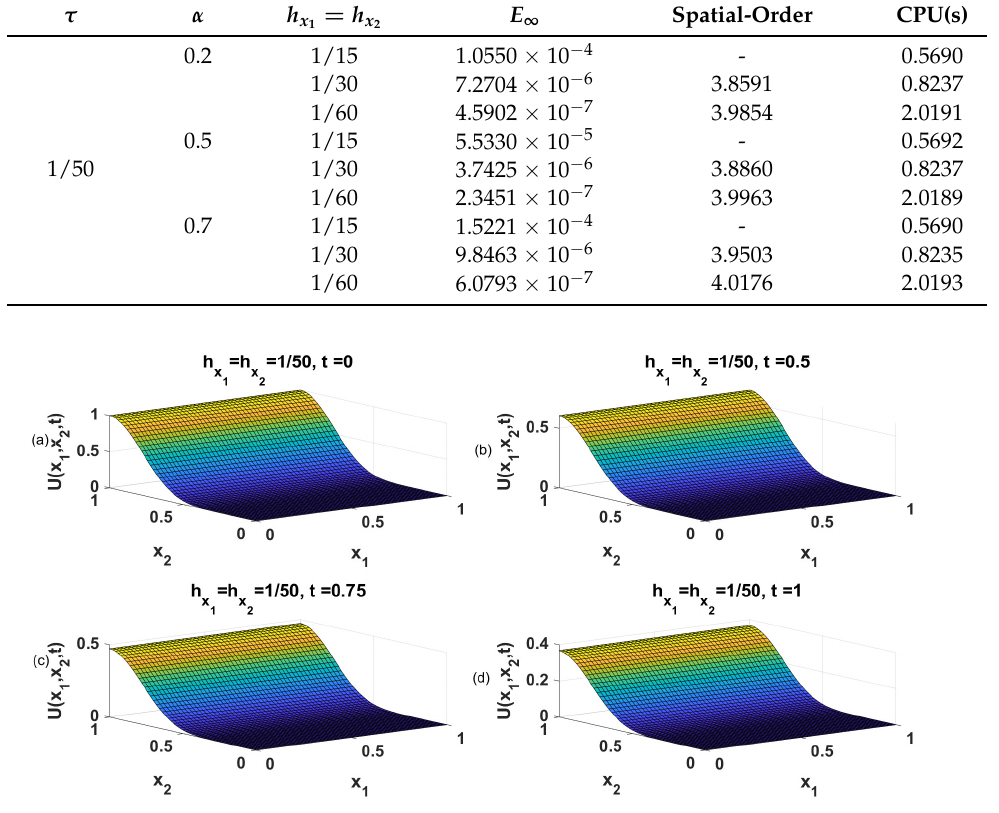
Figure 1. The numerical solutions for Example 1 for different time values ( a : t = 0, b : t = 0.5, c : t = 0.75, d : t =